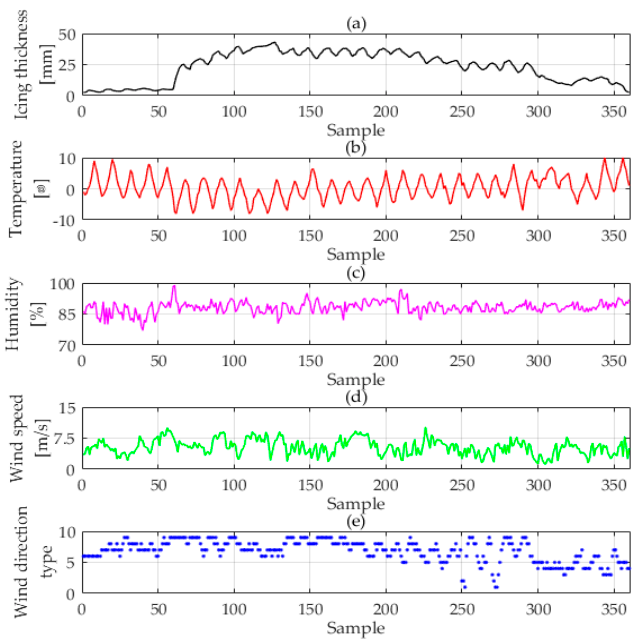
Figure 7. Original data of icing thickness, temperature, humidity, wind speed, and the processing data of wind direction. Note: ( a ) represents the original data of icing thickness; ( b ) represents the original data of temperature; ( c ) represents the original data of humidity; ( d ) represents the original data of wind speed; ( e ) represents the processing data of wind direction. Table 4. Results of the k-fold cross validation.